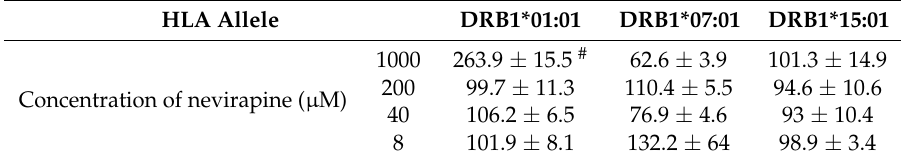
Table 2. The effect of nevirapine on the binding of ligand peptides to HLA-DR molecules. HLA Allele